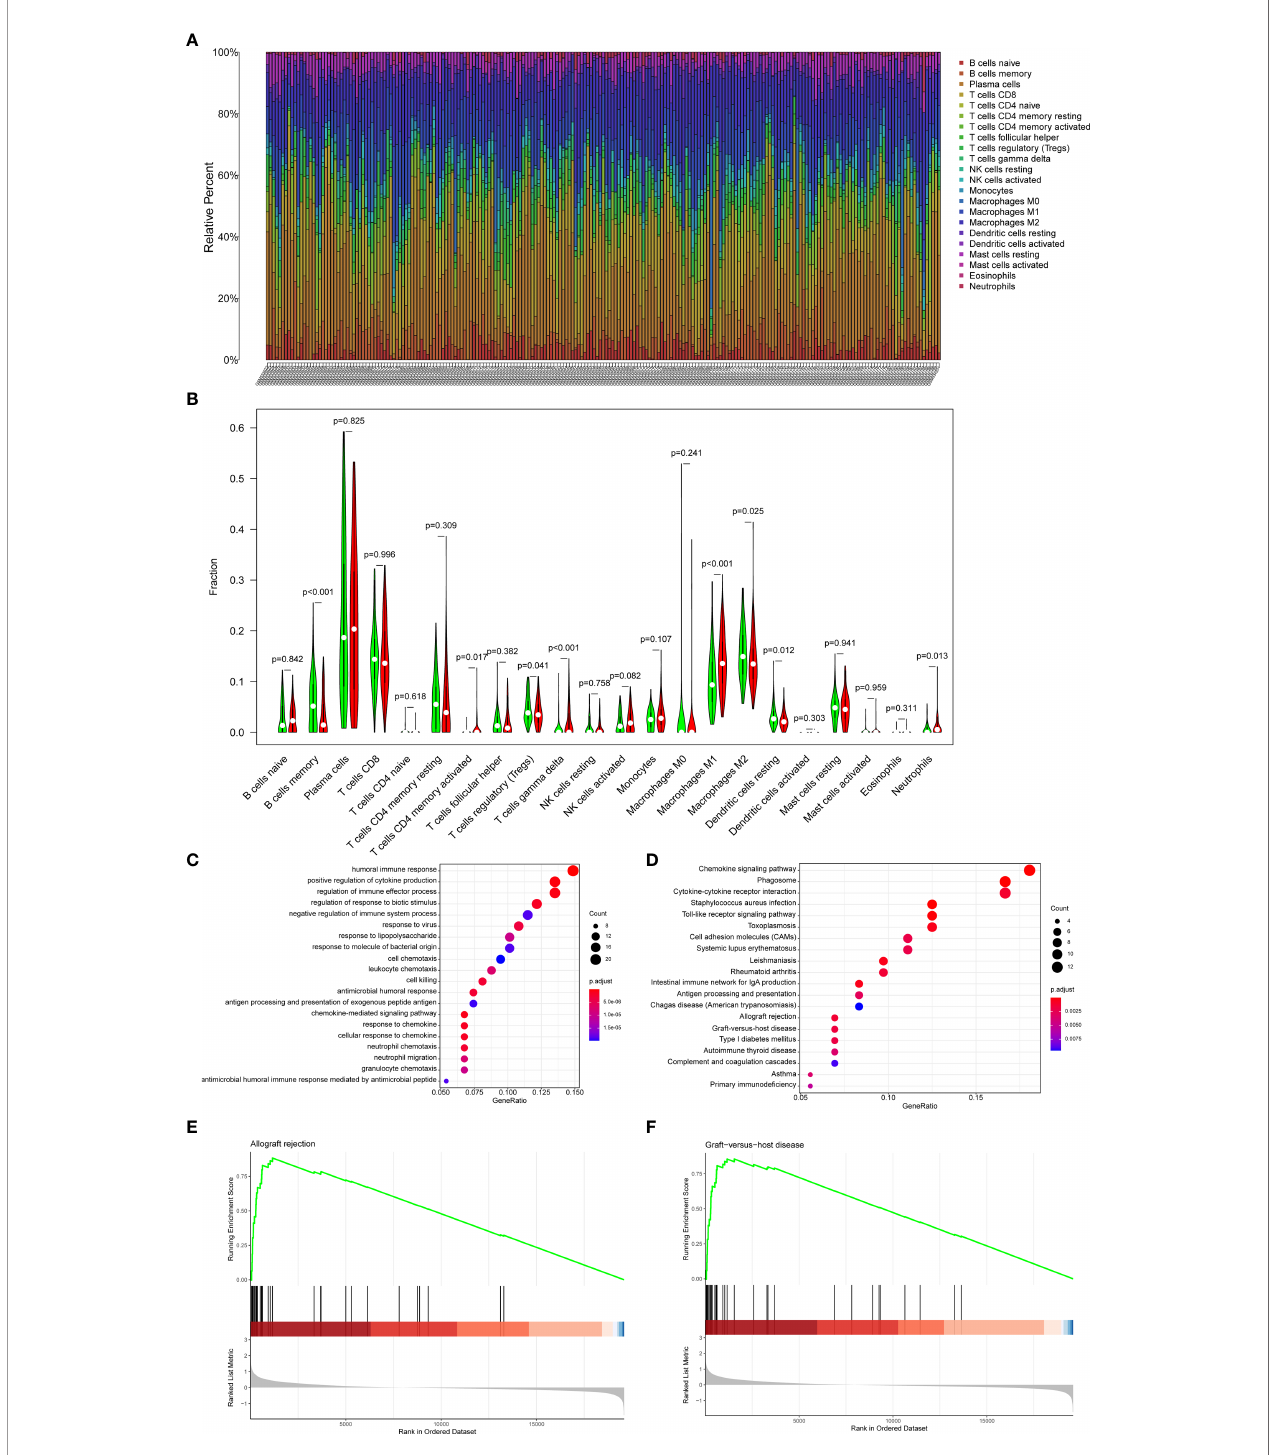
FIGURE 8 | Immune cell proportions in the GSE21374 dataset. (A) A bar plot of the immune cell proportions in the low-risk and high-risk groups. (B) A violin plot of the immune cell proportions in the low-risk and high-risk groups. Blue and red colors represent low-risk and high-risk samples, respectively. (C) GO functional enrichment analyses. (D) KEGG functional enrichment analyses. (E, F) The GSEA enrichment